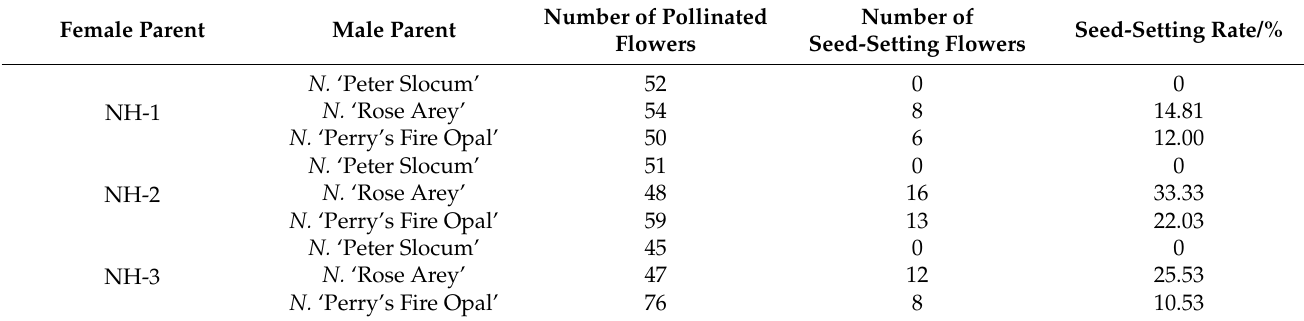
Table 5. Comparison of the seed-setting rates of different hybrid